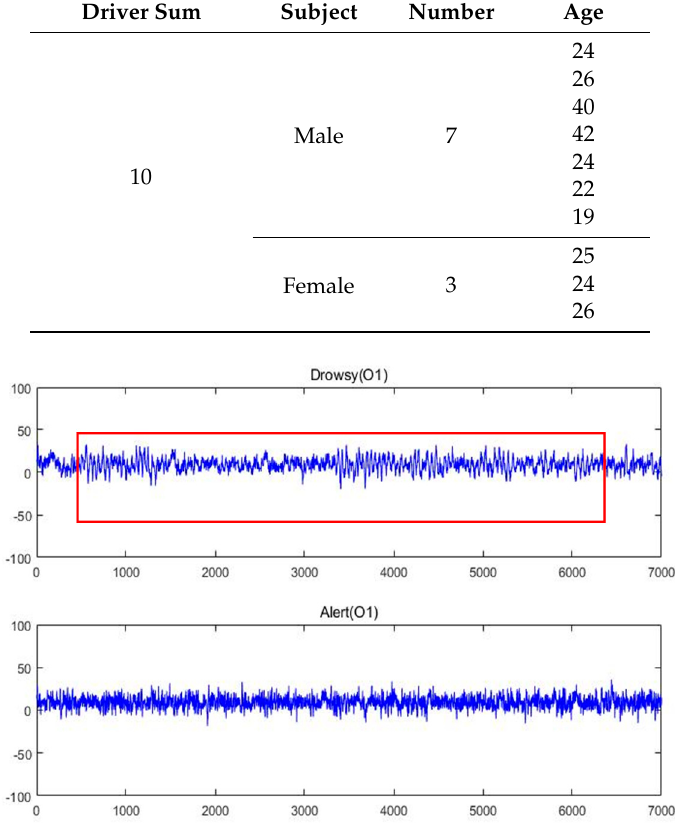
Table 5. Ten drivers served in the experiment.